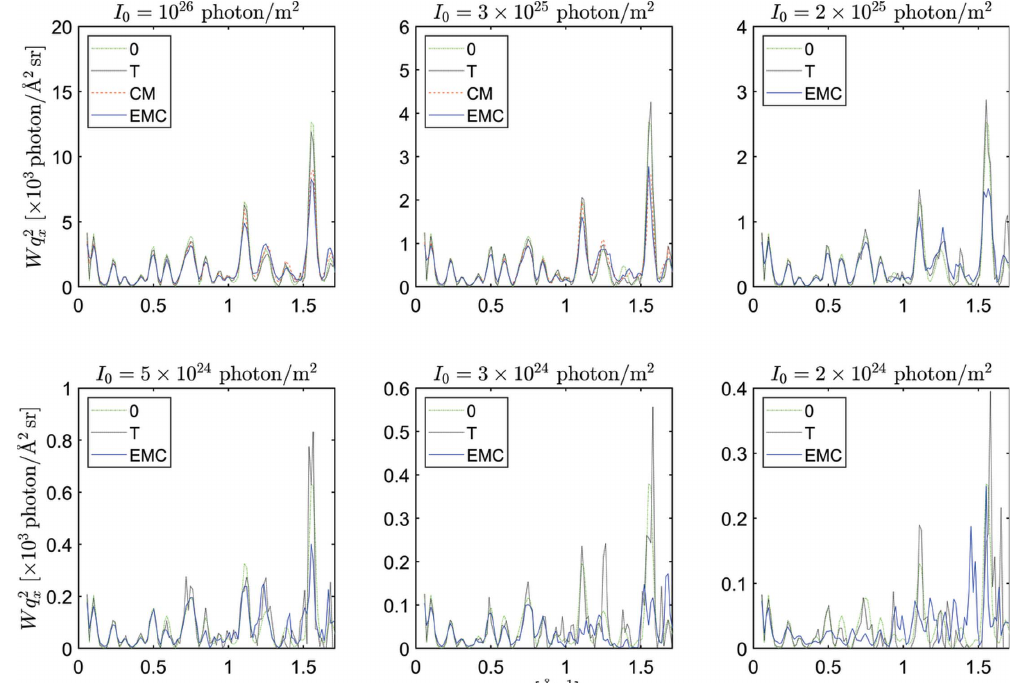
Figure 6 Intensity W reconstructed by the EMC (blue solid line) method, the CM (red dashed line) method, and using the true orientations ( W T , black dotted line) for RNA polymerase II along a radial direction at various incident XFEL fluences I 0 (indicated at the top of the panels). The shape of the noiseless model intensity ( W 0 , green dash-dotted line) is independent of I 0 .